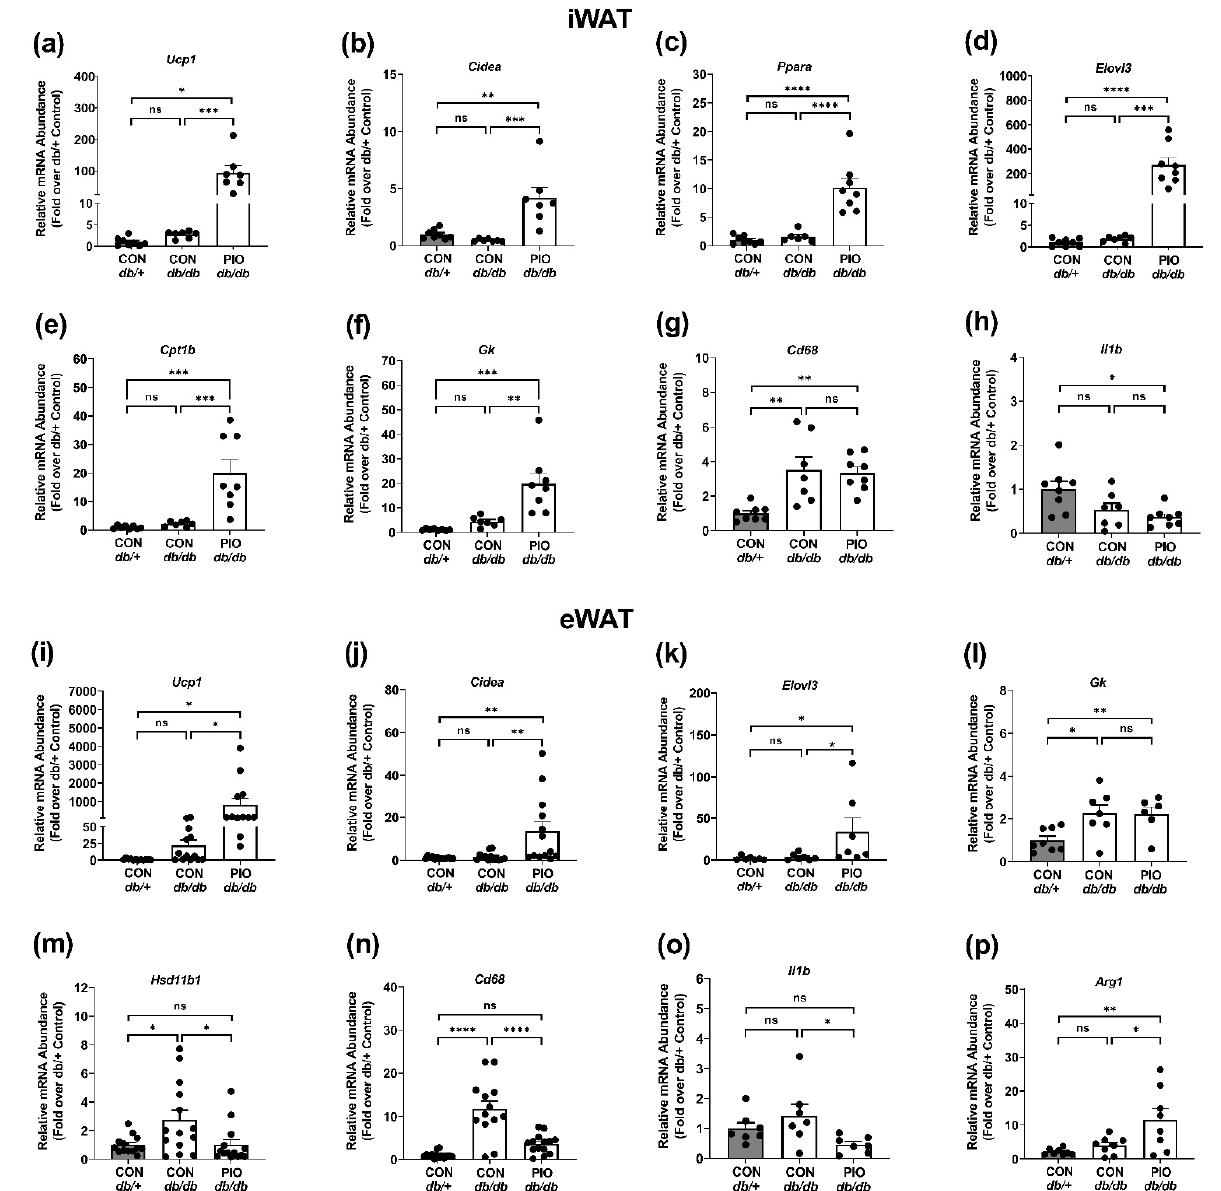
Figure 5. PIO alters expression of genes involved in browning, fatty acid oxidation, and inflammation in white adipose tissue of db/db mice. mRNA abundance of ( a ) Ucp1 , ( b ) Cidea , ( c ) Ppara , ( d ) Elovl3 , ( e ) Cpt1b , ( f ) Gk , ( g ) Cd68 , and ( h ) Il1b in iWAT from db/+ mice on a CON diet (gray bars) and db/db mice on either a CON- or PIO-supplemented diet (white bars) for 4 w. Gene expression analysis of ( i ) Ucp1 , ( j ) Cidea , ( k ) Elovl3 , ( l ) Gk , ( m ) Hsd11b1 , ( n ) Cd68 , ( o ) Il1b , and ( p ) Arg1 in eWAT from db/+ mice on a CON diet (gray bars) and db/db mice on either a CON- or PIO-supplemented diet (white bars) for 4 w. n = 8–14 per group. Values are represented as the means ± SEM. * p < 0.05, ** p < 0.01, *** p < 0.001, **** p < 0.0001. ns, not significant.